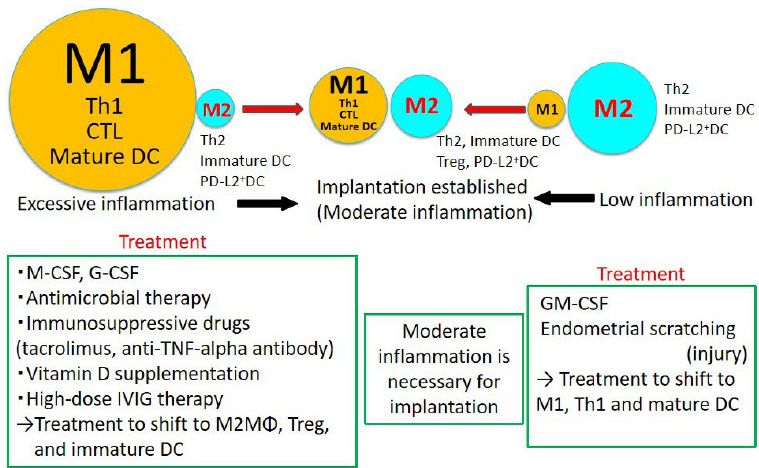
Figure 2. New treatment strategies for implantation failure. Inflammation is necessary for implantation, but too much or too little inflammation may lead to implantation failure. Therefore, we propose that implantation failure be treated separately in cases of excessive inflammation and low inflammation. When the endometrial immune state shows M1 macrophage predominance, Th1 predominance, increased cytotoxic T lymphocytes (CTL) and increased mature DCs, methods to reduce inflammation may be beneficial conversely. In situations where there is little inflammation, methods that activate the immune system may be